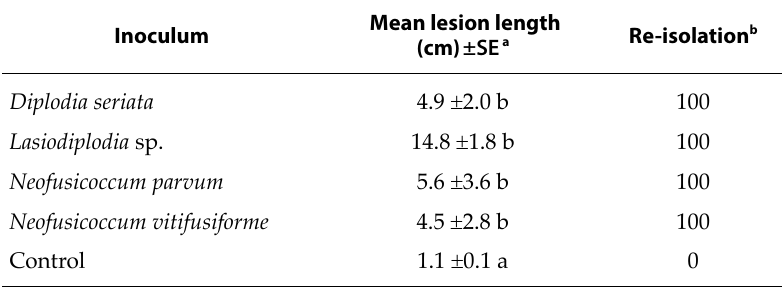
Table 4. Mean lesion length on excised grapevine green shoots cv. Insolia 21 days after artificial inoculation with Botry - osphaeriaceae